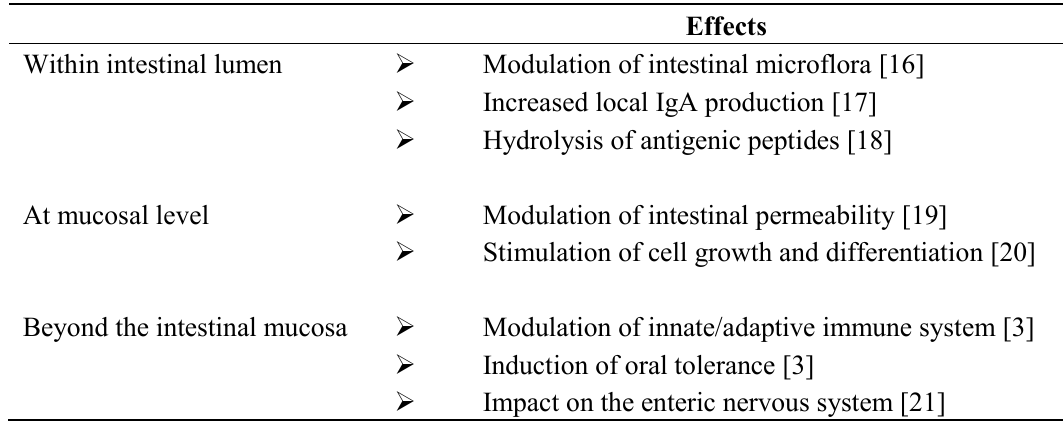
Table 1. Schematic representation of the mechanisms of action of probiotics implicated in allergy prevention and